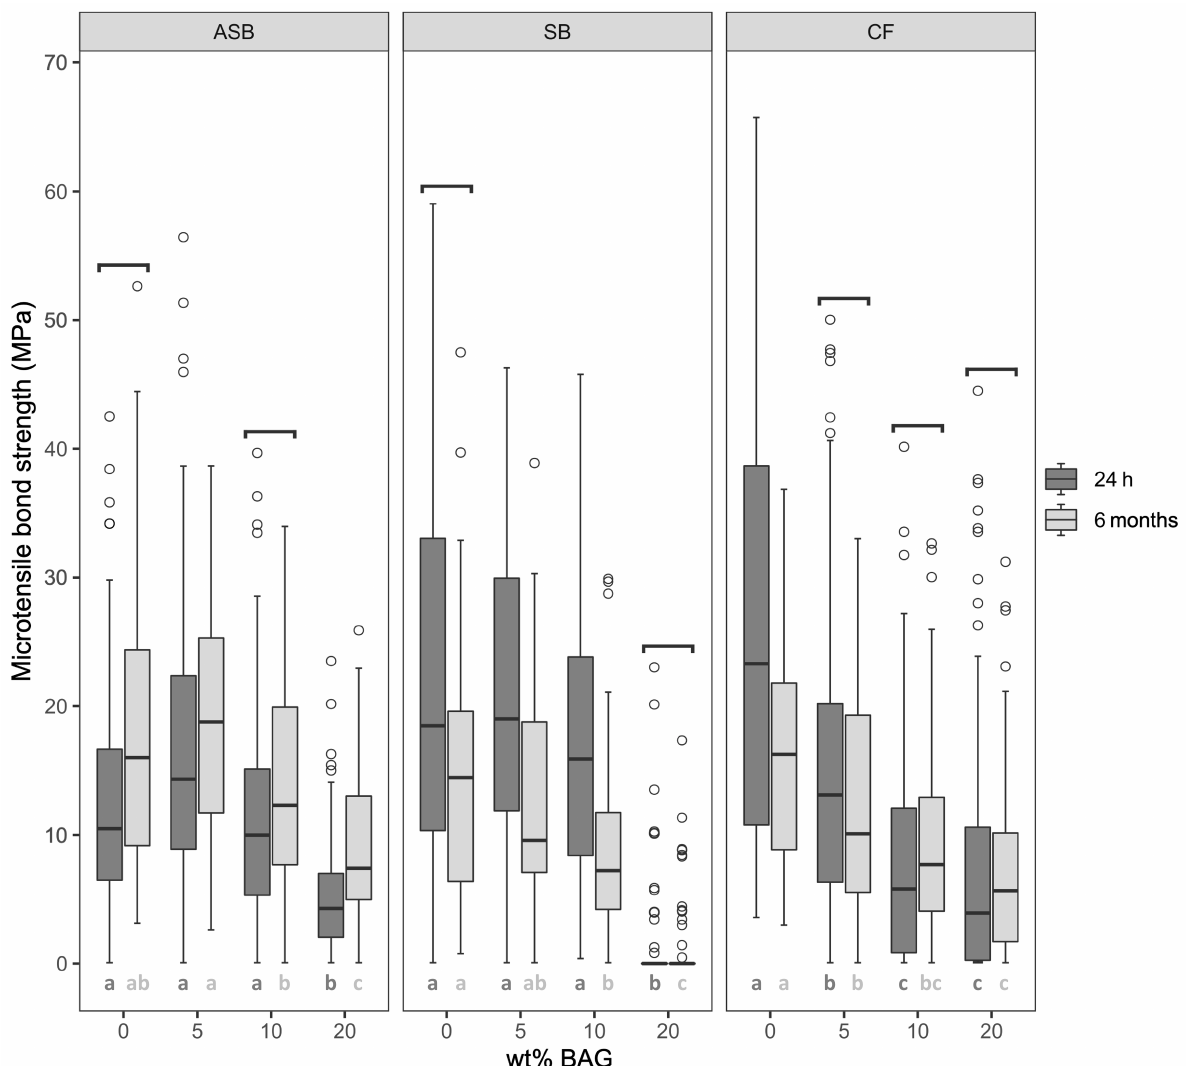
Figure 2. Micro-tensile bond strength ( µ TBS, in MPa) after 24 h and 6 months of storage in simulated body fluid (SBF). Boxplots show the medians (black lines) with 25 and 75% quartiles (boxes). The whiskers represent 1.5 × interquartile range (IQR), or minima and maxima of the distribution if below 1.5 × IQR. Outliers are shown as circles. The brackets above the box plots indicate no statistically significant differences ( p ≥ 0.05) in µ TBS between storage times. Statistically significant differences ( p < 0.05) in µ TBS within the adhesive groups on the level of bioactive glass content are marked with different letters. Dark gray letters refer to 24 h values, light gray letters refer to 6 months values. ASB: Adper Scotchbond Multi-Purpose; SB: Solobond Plus; CF: Clearfil SE Bond; BAG: bioactive glass 45S5.